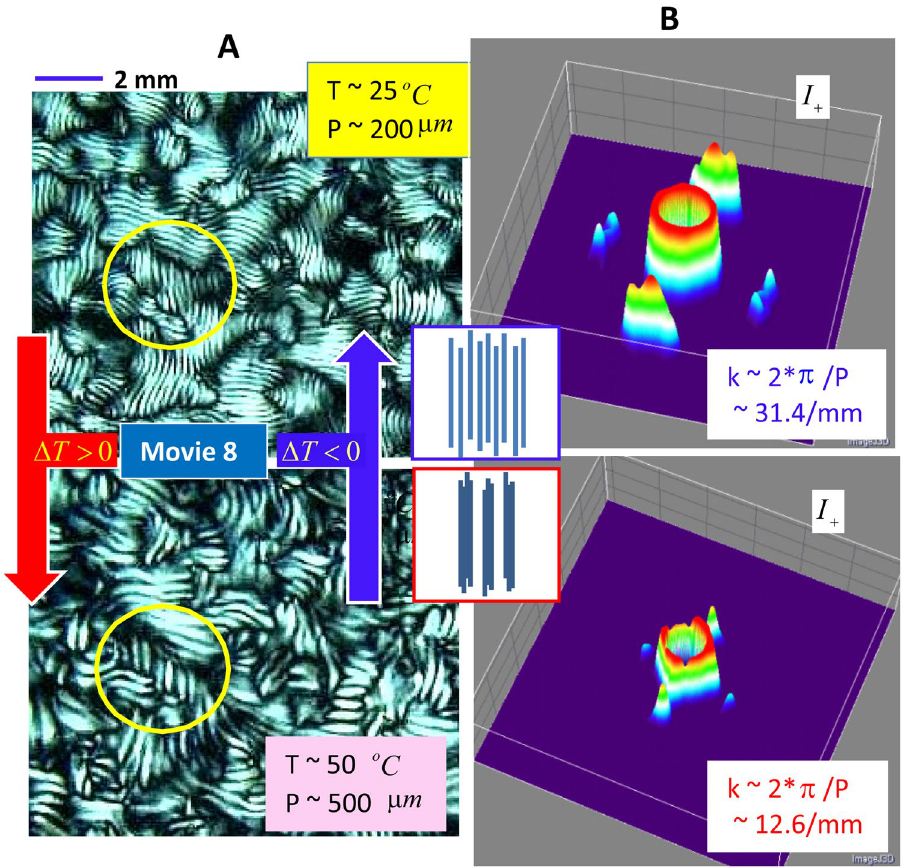
Figure 8. Thermal stability of chiral-nematic, N-star (N*) orientation texture: Thermal response of the optical pitch variances of a chiral-nematic N-star (N*) phase of a low ionic strength of 0.032 mM salt in real space ( A ), and the corresponding Fourier transforms in 3D intensity profiles (6) The temperature swap occurs for two different temperatures of 25 ◦ C (upper) and 50 ◦ C (lower), respectively, by a 3D intensity map obtained by a software version ImageJ 1.52i in the URL link https ://image j.nih.gov/ij/. Movie 8 shows supplementary data for the reversible pitch length between 200 µ m (at room temperature, 25 ◦ C) and 500 µ m, when the temperature is increased to 50 ◦ C. The temperature increases to the higher value over the first half of the duration and decreases to the lower value over the other